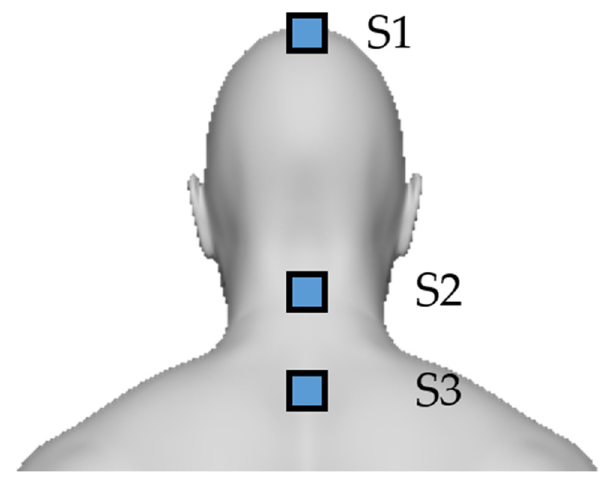
Figure 7. The scheme of IMU based method.